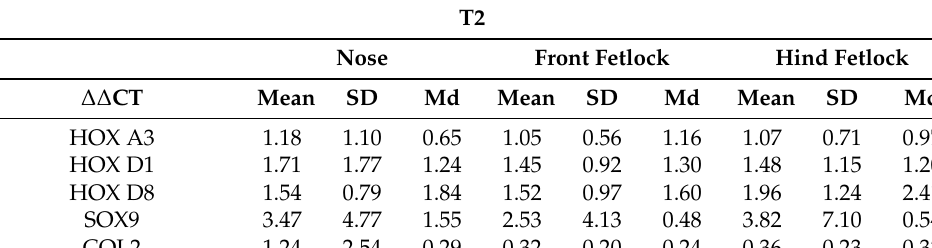
Table 3. Descriptive statistics for T2.